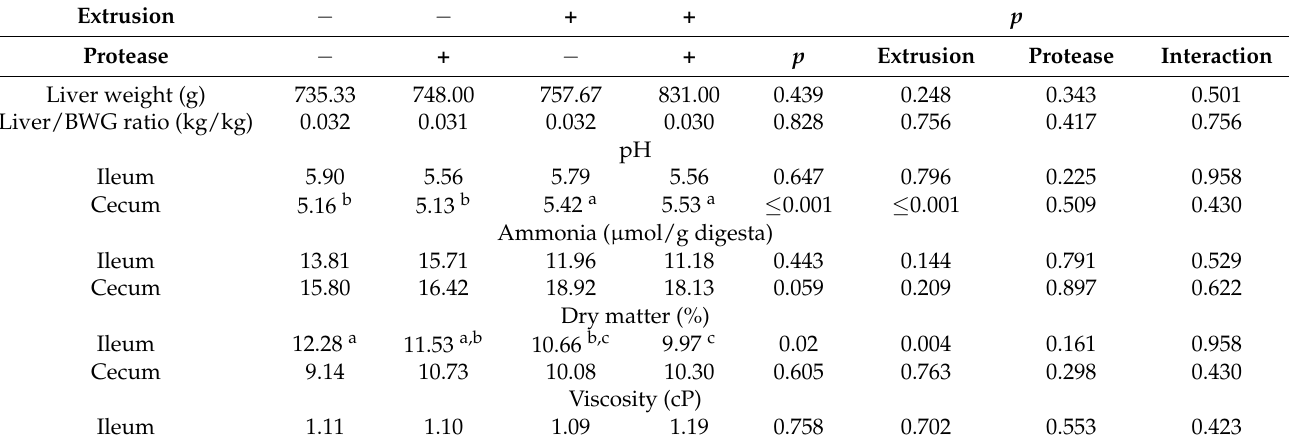
Table 5. The physical parameters of the liver, digesta pH, ammonia concentration, dry matter content, and viscosity in the ileum and cecum ( n =